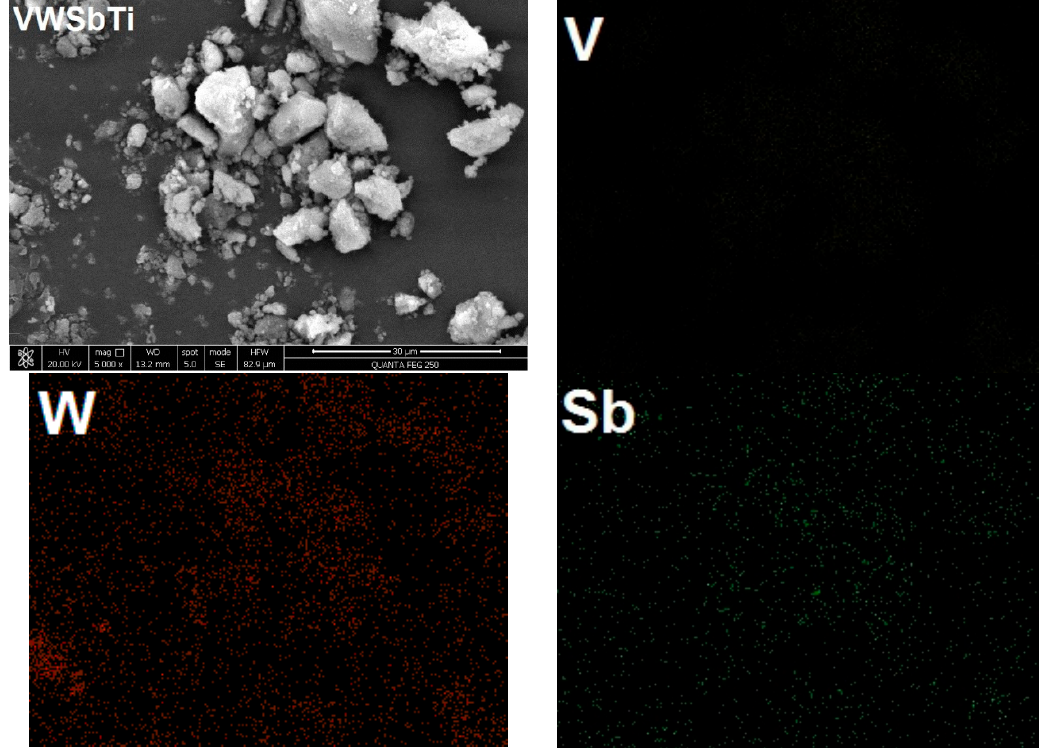
Figure 3 . SEM mapping photograph of V, W, Sb within a local part of the VWSbTi sample.